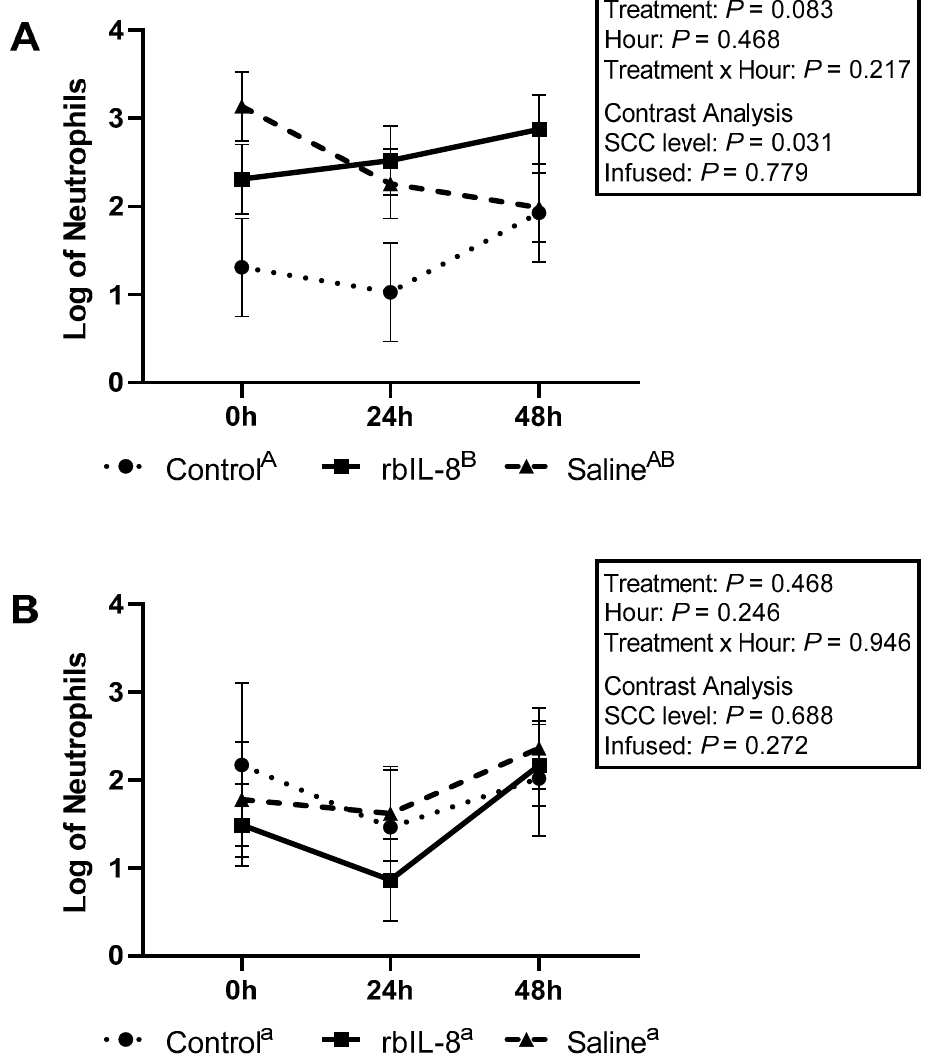
Figure 3. Log of neutrophils isolated from milk ( A ) and from blood samples ( B ) that presented a high fluorescence only for propidium iodide (PI) relative to hours post-treatment based on flow cytometry. The treatment effect refers to multiple comparisons among the groups. The SCC level was performed using a contrast comparing the chronic groups (rbIL-8 and saline) versus control, whereas the infused was compared only the rbIL-8 with the saline. Multiple comparisons were adjusted for Tukey–Kramer. Groups with different superscripts a,b differed, and A,B presented a tendency for the mean ± SE of log of neutrophils, in the multiple comparison analysis; p = ≤ 0.05 means a statistical significance, and 0.05 < p ≤ 0.10 means a statistical tendency.